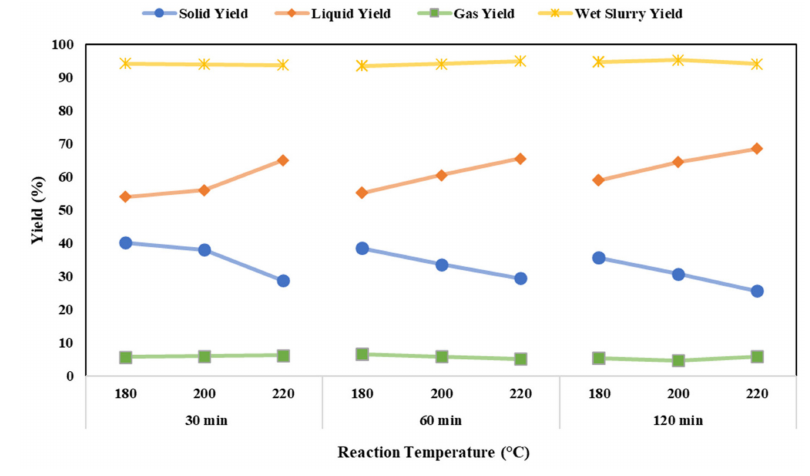
Figure 3. Effect of the reaction temperature on the product yields in HTC.